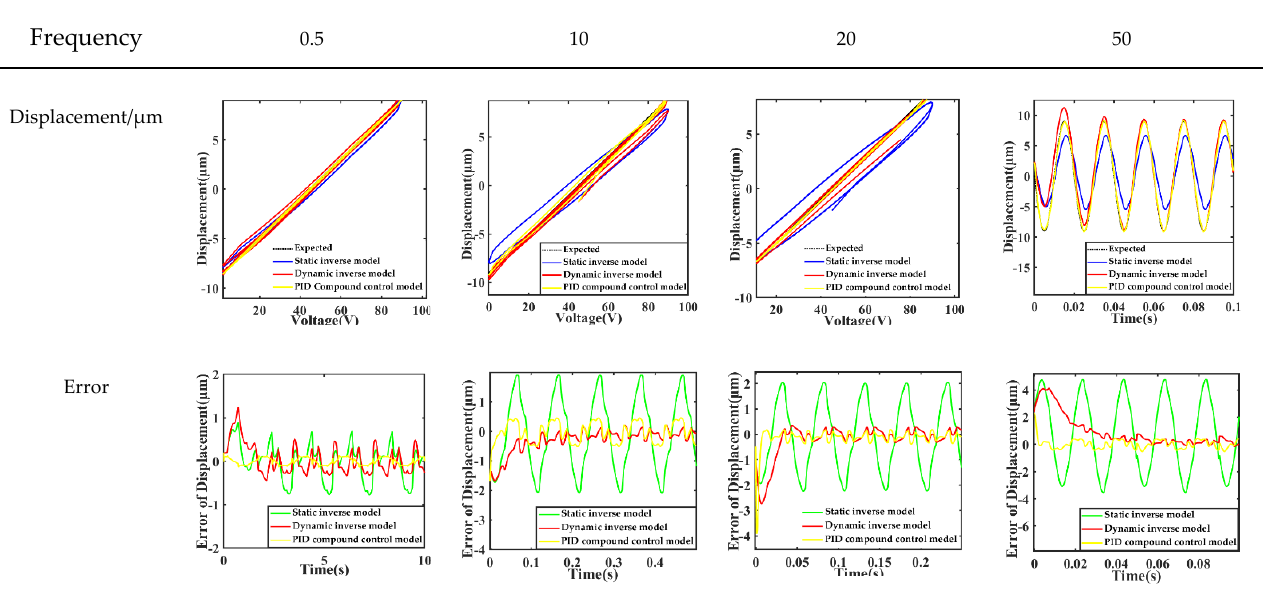
Figure 9. The results of displacement of different control systems.